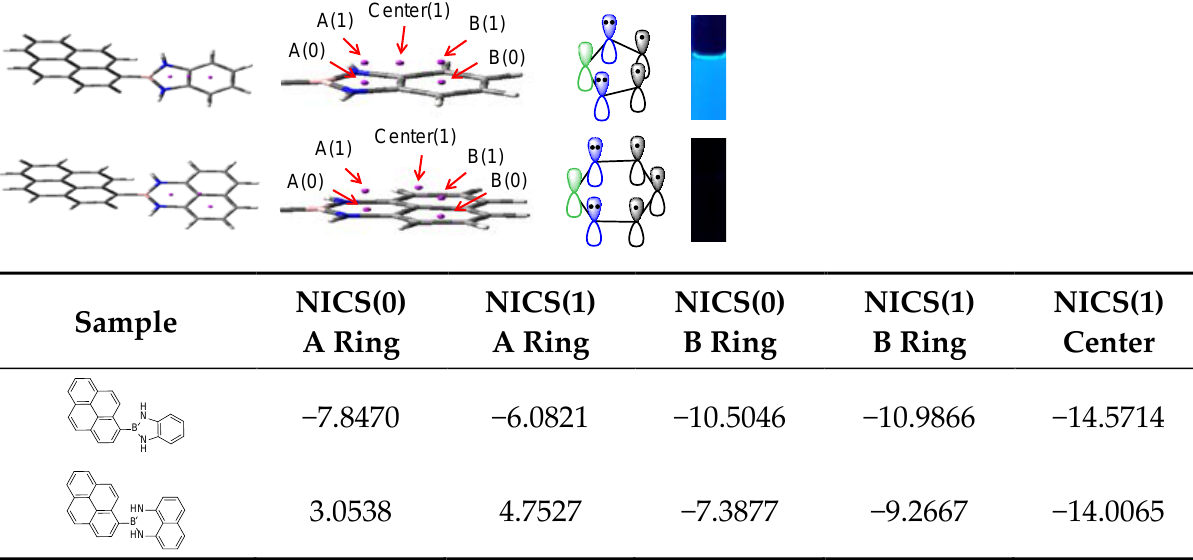
Figure 1. Electron orbital of NBN-doped PAHs, corresponding to the NICS calculation model and NICS values. The photographs in the upper right corner are fluorescent images of Py-NBN-Ph ( up ) and Py-NBN-Naphth ( down ) in THF solution (0.1 mg/mL) under the UV light.